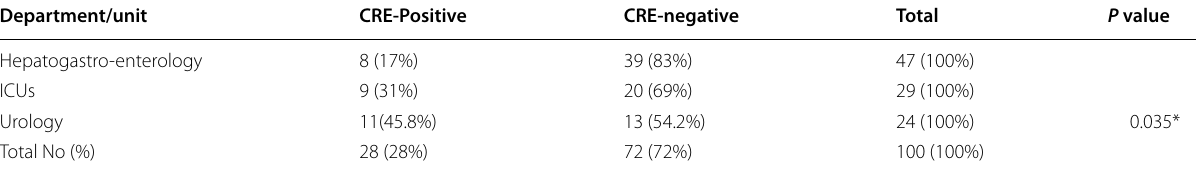
Table 1 Distribution of CRE isolates among the different hospital departments